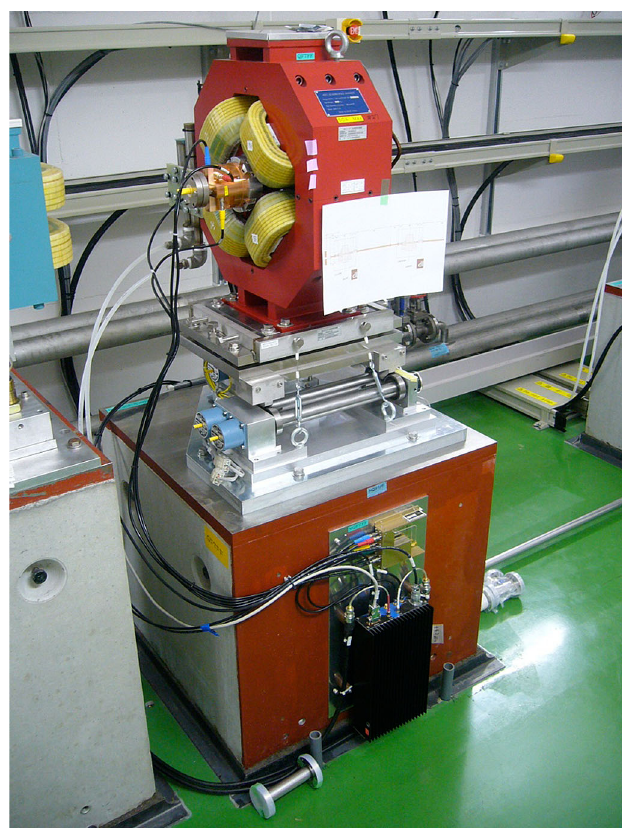
FIG. 1. Nominal ATF2 final focus optics. FIG. 2. A C-band BPM inside of a quadrupole on a mover.